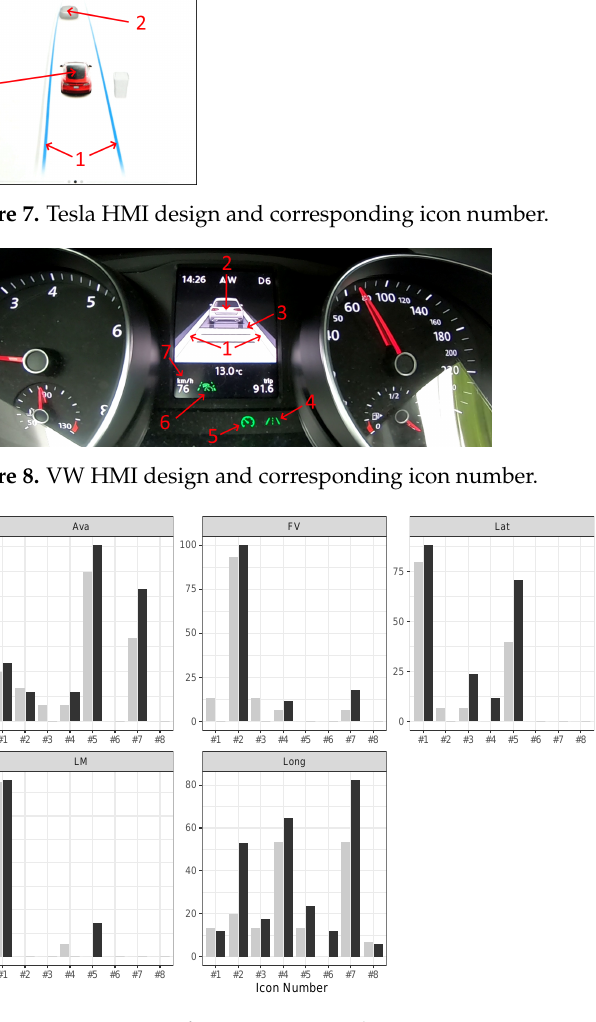
Figure 9. Percentages of BMW icons used to answer TRASS questions from participants with high and low